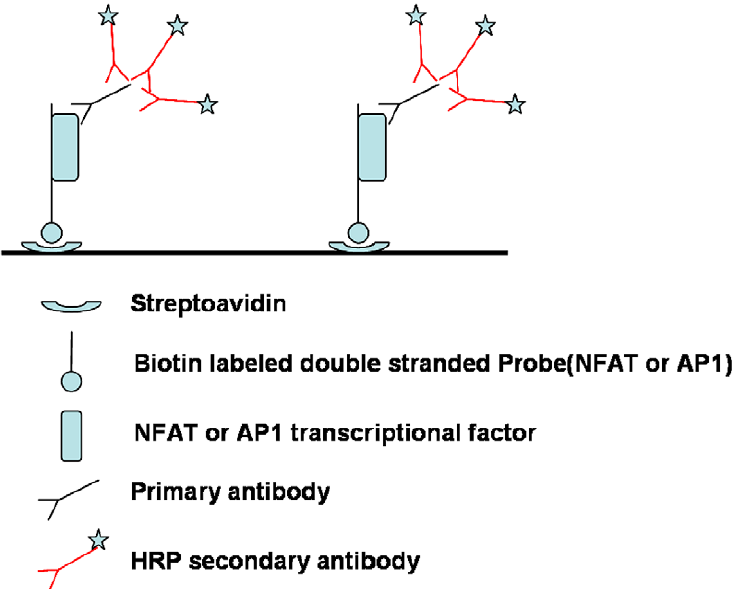
Fig. 3B. Scheme of transcriptional-DNA binding assay. Biotin labeled double stranded NFAT or AP1 decoy ODN were added to strepta- vidin-coated 96-well plates. 10 µg of nuclear extracts were added. After incubation for 2 h unbound proteins were washed away, bound proteins were identified with rabbit anti NFAT, rabbit anti C-fos or rabbit ant C-jun antibody. HRP labeled anti-rabbit secondary antibody was then added and incubated for 30 min. After washing, TMB substrate was added for color development, and plates were read at 450 nm with EL311 plate